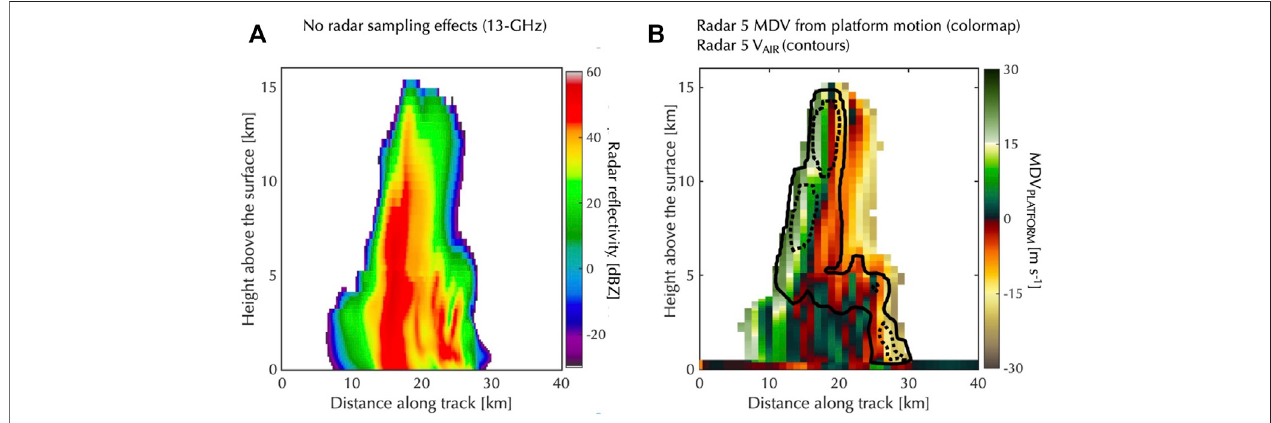
FIGURE 6 | Forward simulation of TRMM-LBA weakly organized convection: (A) radar re fl ectivity at 13 GHz without radar sampling effects and (B) apparent MDV inducedstrictly fromplatformmotionandNUBF conditionsforradar5(i.e.,airmotionandparticlesedimentationsetto0 m s -1 ).Overlaidon “ b ” areV AIR contours drawn